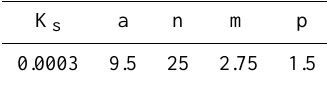
Table 4. Influence of the soil type; permeability parameters for clay and silt.